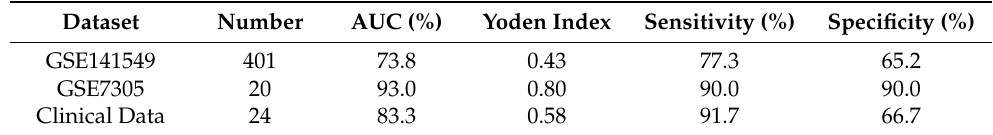
Table 3. Sensitivity and specificity of ASPN in internal and external